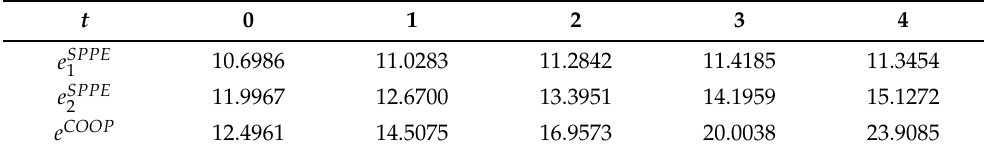
Table 1. SPPE strategies and cooperative strategy.